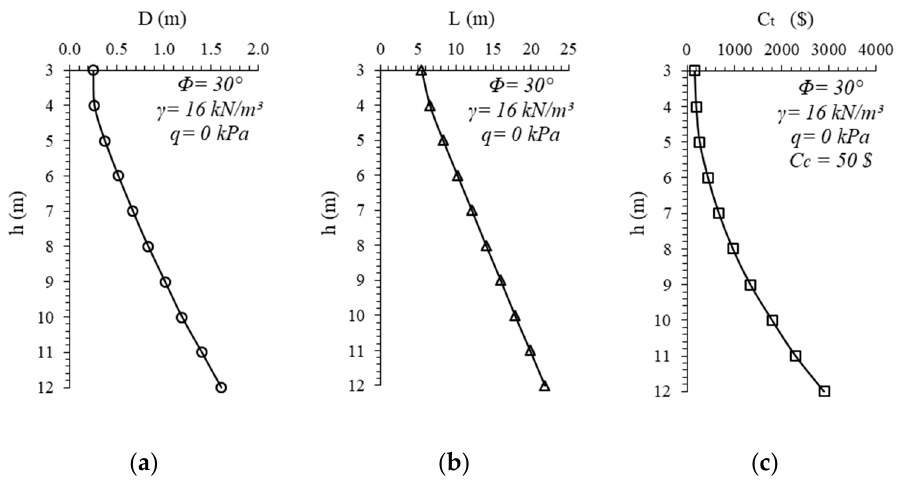
Figure 2. Change of the diameter of cantilever soldier pile ( a ), the length of pile ( b ), and the unit cost of concrete ( c ) via excavation depth.